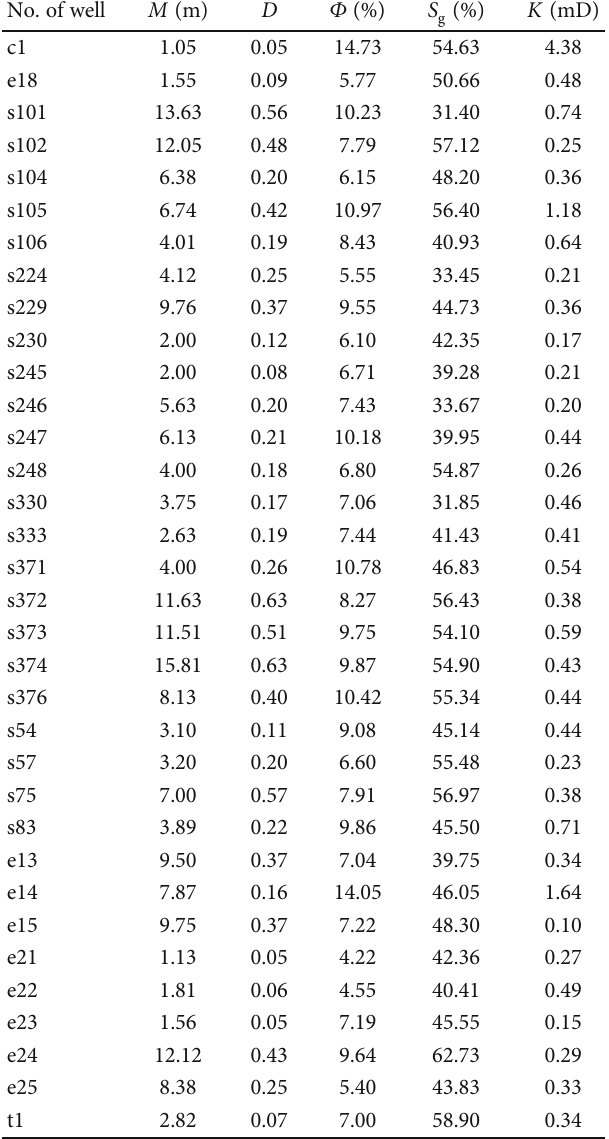
Table 1: Parameters of wells in P Sulige gas fi eld.